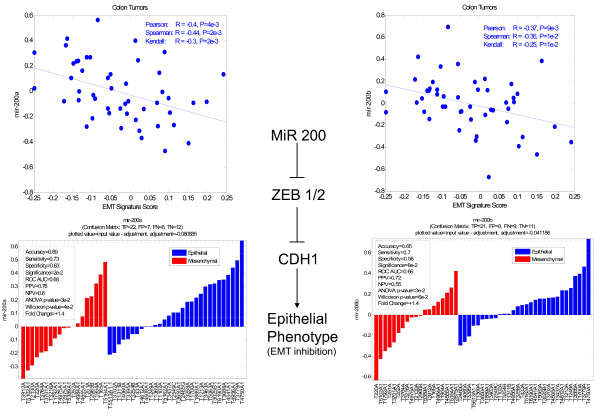
Correlation of microRNA analysis (~700) with PC1/EMT across 49 colorectal cancers identified the MiR200 family as strongly, negatively correlated with PC1/EMT (upper plots). The Mir 200 family has been linked to inhibition of EMT (promotion of the epithelial phenotype) through inhibition of Zeb 1 & 2, known transcriptional repressors of CDH1. Waterfall plots show MiR 200 over-expression is correlated with more tumors classified as epithelial than mesenchymal and Mir 200 under-expression is correlated with fewer epithelial than mesenchymal tumors (lower plots).